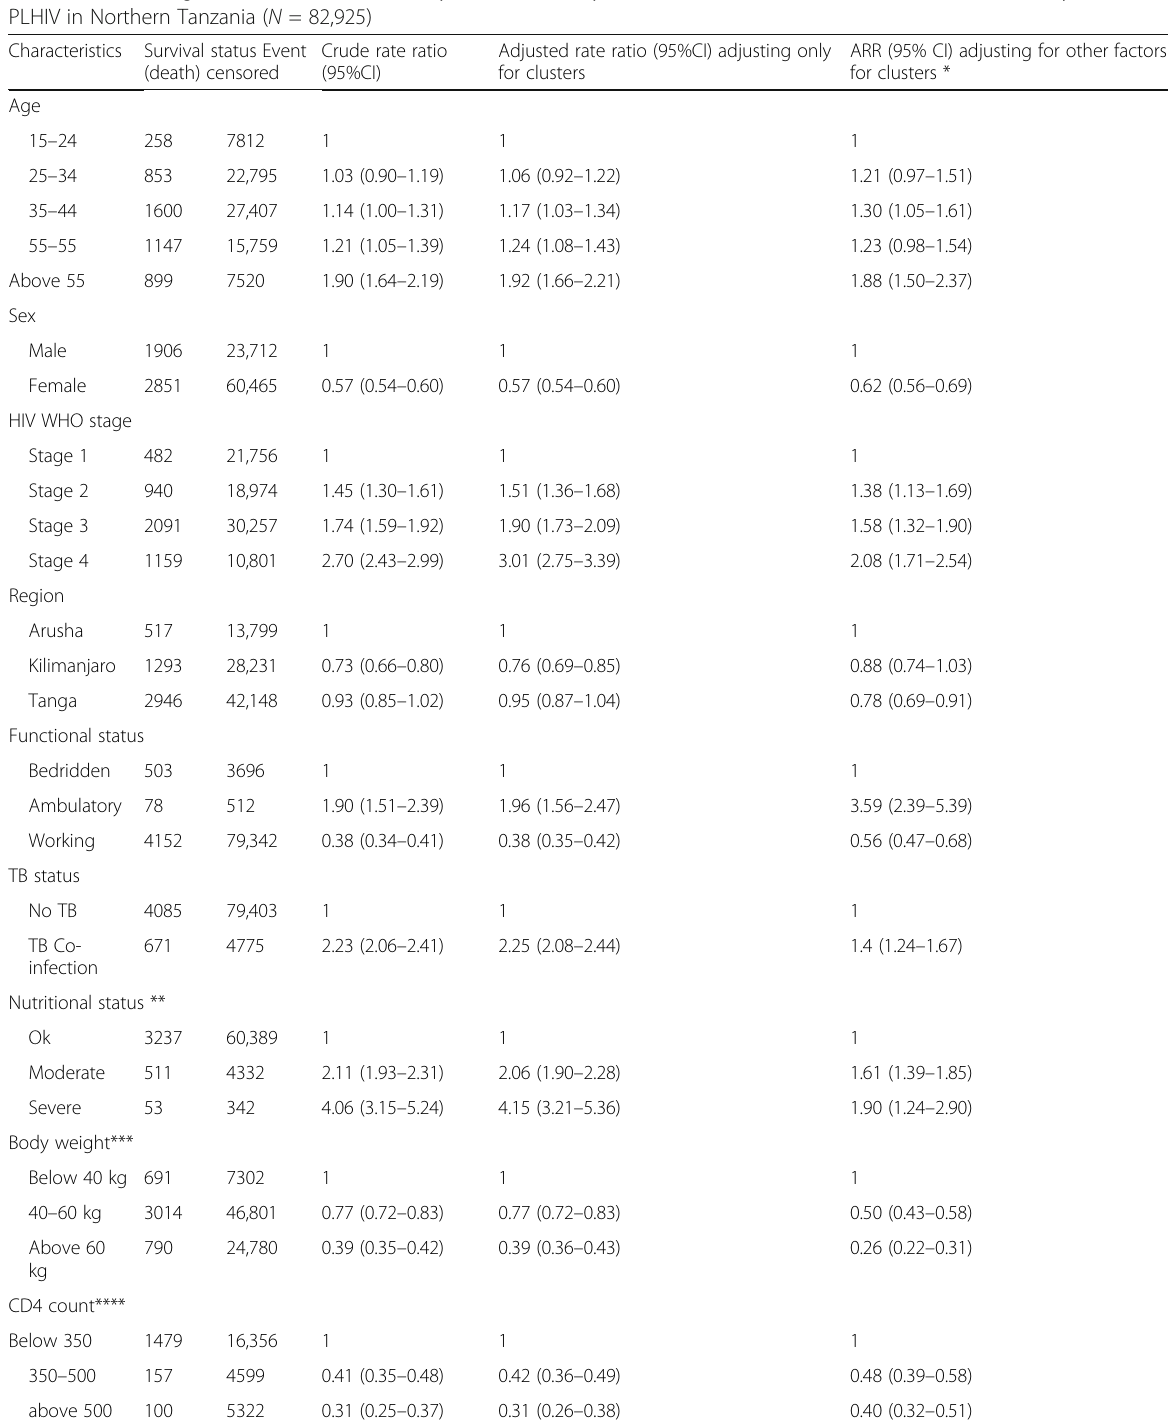
Table 3 Poisson regression with multilevel analysis (health facility as cluster variable) of the determinants of mortality rates among PLHIV in Northern Tanzania ( N =